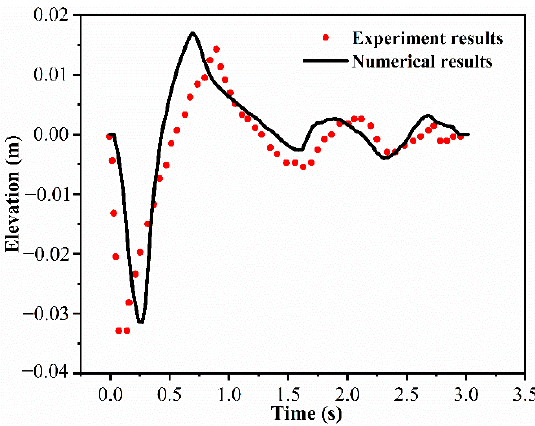
Figure 2. Comparison of water surface fluctuation in near-field area of Case 76 between the experi- ment and numerical calculation.